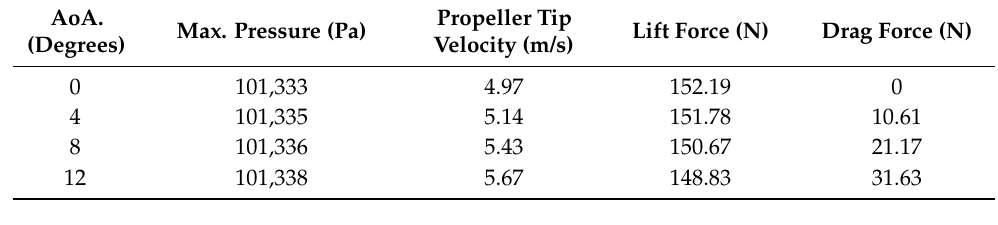
Figure 25. UAV with Computational domain.